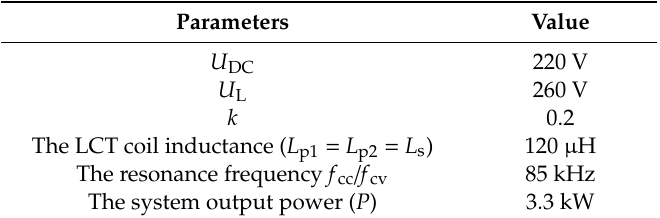
Figure 8. Loosely coupled transformer (LCT) structure in IPT system with ( a ) main view and ( b ) front view. Table 1. Parameters in IPT system.